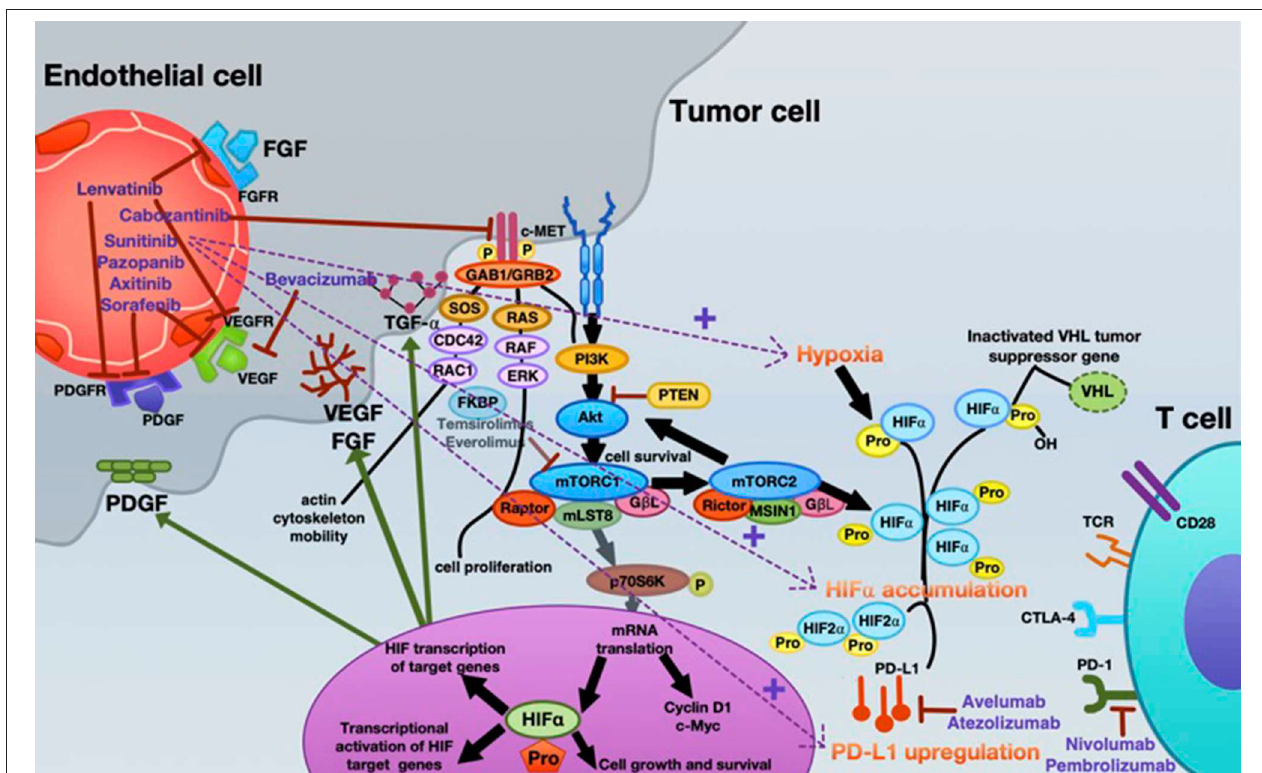
FIGURE 2 | Mechanistic interactions between VEGF-targeted anti-angiogenic therapy and checkpoint inhibitors in the systemic treatment of mRCC. Various VEGF-targeted and mTOR-targeted anti-angiogenic agents are currently approved in mRCC, inhibiting VEGF-A (bevacizumab); VEGFR1-3, FGFR1-4, PDGFR- α , c-kit, and RET-oncogene (lenvatinib); c-MET, AXL and RET, and VEGFR2 (cabozantinib); c-KIT, FGFR, PDGFR, and VEGFR (pazopanib); VEGFR1-3, c-KIT, and PDGFR (axitinib); VEGFR, PDGFR, and Raf family kinases (sorafenib); VEGFRs, PDGFRs, and RET (sunitinib). Everolimus and temsirolimus are specific inhibitors of mTOR and interfere with the synthesis of proteins that regulate proliferation, growth and survival of tumor cells. These agents are more selective for the mTORC1 protein complex, with very little impact on the mTORC2 complex. Nevertheless, increased tumor hypoxia during this anti-angiogenic therapy is the key player for developing TKI resistance, with consecutive HIF- α accumulation. Under hypoxia, PD-L1 upregulation was dependent on HIF-2 α in RCC, being associated with simultaneous VEGF overexpression. Moreover, specimens from patients treated with anti-angiogenic therapy were associated with enhanced expression of PD-L1 (1). Thus, combined blockade of PD-L1 (avelumab or atezolizumab) or PD-1 (nivolumab or pembrolizumab) along with inhibition of the angiogenesis pathway is an innovative therapeutic concept in